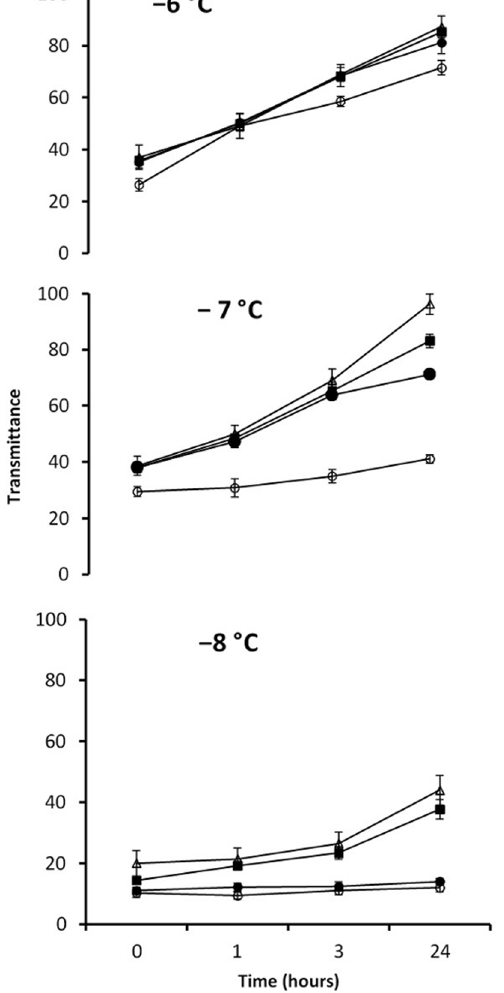
Fig 5. The effect of time on optical transmittance (arbitrary units) in the recrystallometer. Pure nematode extract (open circles), buffer (triangles), a 1:1 dilution of extract with buffer (closed circles) and a 1:3 dilution (squares) at annealing temperatures: -6°C (top graph), -7°C (middle graph) and -8°C (bottom graph). Means ± SD, N = 3.